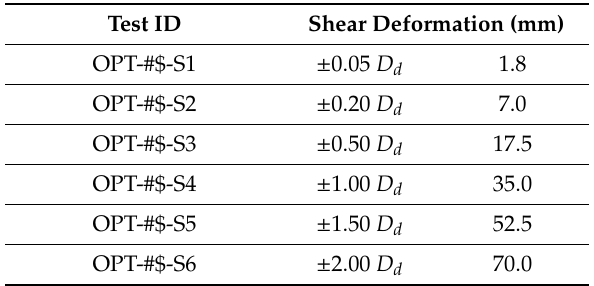
Table 5. Test matrix for shear deformation